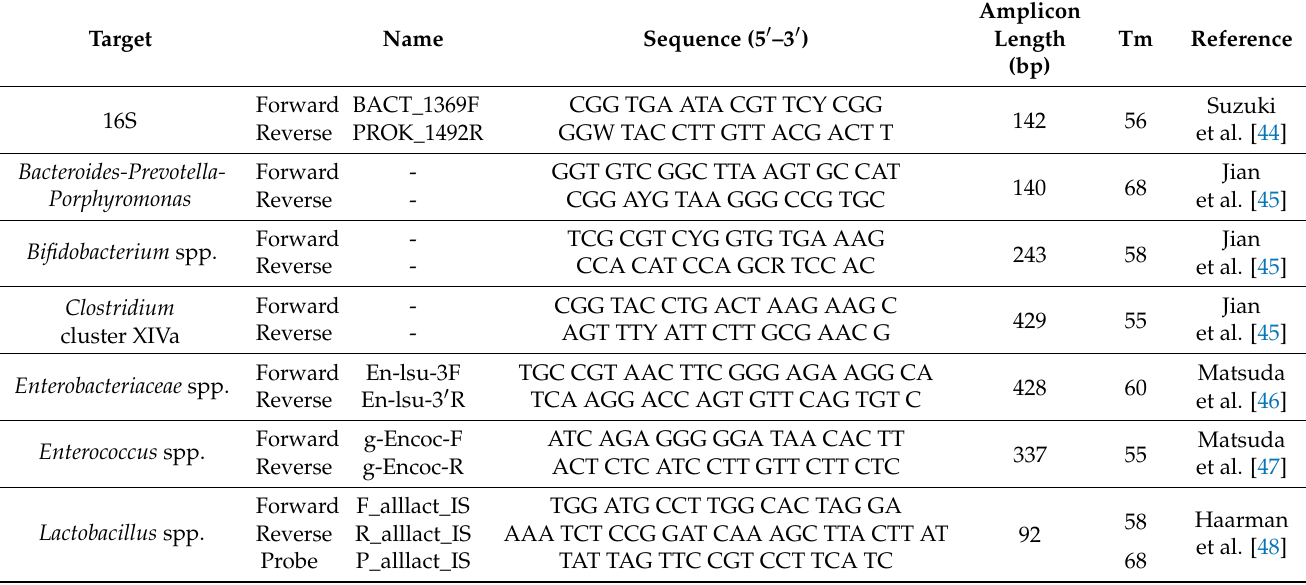
Table 1. Primer sequences targeting genera within the preterm core microbiota. Overview of primer sequences to target genus-specific regions of the bacterial 16S rRNA gene for genera within the preterm core microbiota. The subset of selected microorganisms is based on reported core microbiota in preterm infants and on their involvement in the degradation of components in human milk. References of primer sequences and associated methodology are